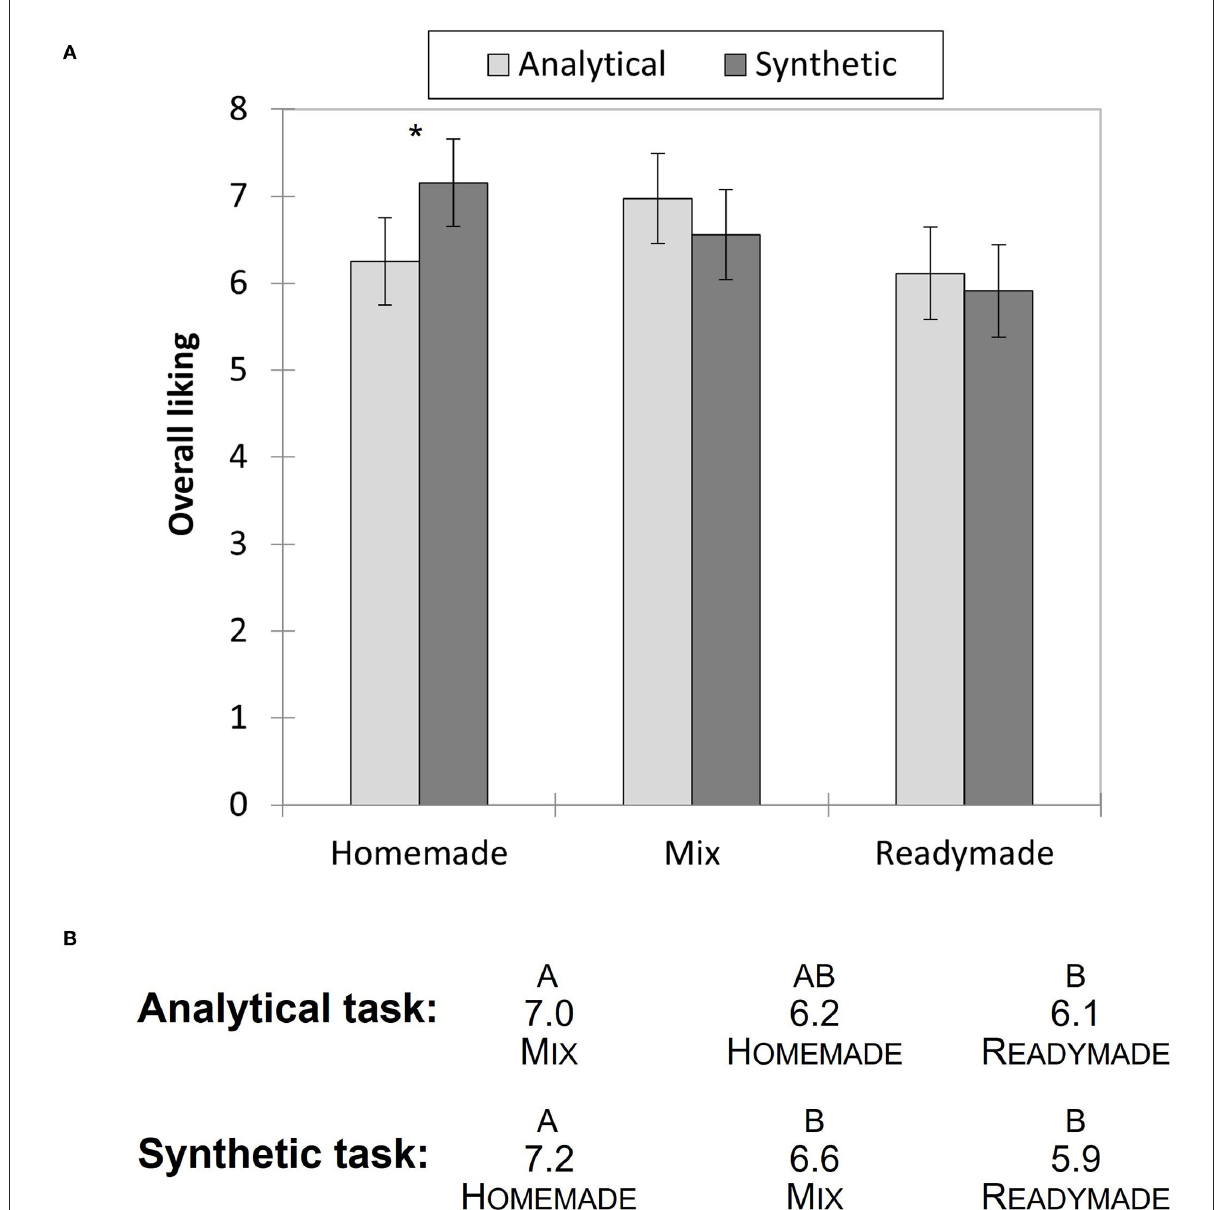
FIGURE3 (A) Mean scores and standard errors for overall liking of the three pizza preparations for each task format, * indicates a significant difference at p < 0.05. (B) Rank order of the different pizza versions for the most liked to least liked according to each evaluation task. Letters above products denote significant differences ( p < 0.05) found between each culinary preparation using post-hoc LSD